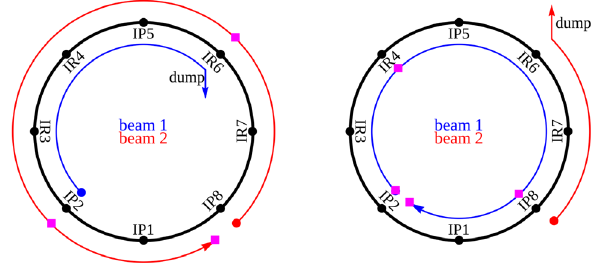
FIG. 16. Schematic top view of the dump of the two beams; for simplicity Beam 1 is shown as the inner and Beam 2 as the outer one. The arrow indicates the beam direction, and the magenta squares show how the beams are split into three different parts when it comes to the BBK. The depicted abort gap is 3 μ s long, and one turn is 89 μ